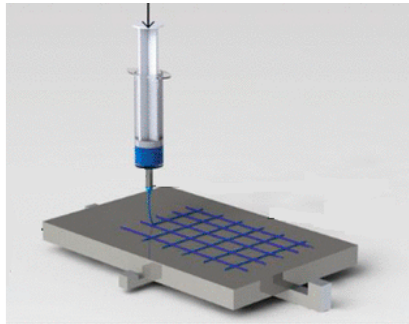
Figure 2. Near-field electrospinning process.